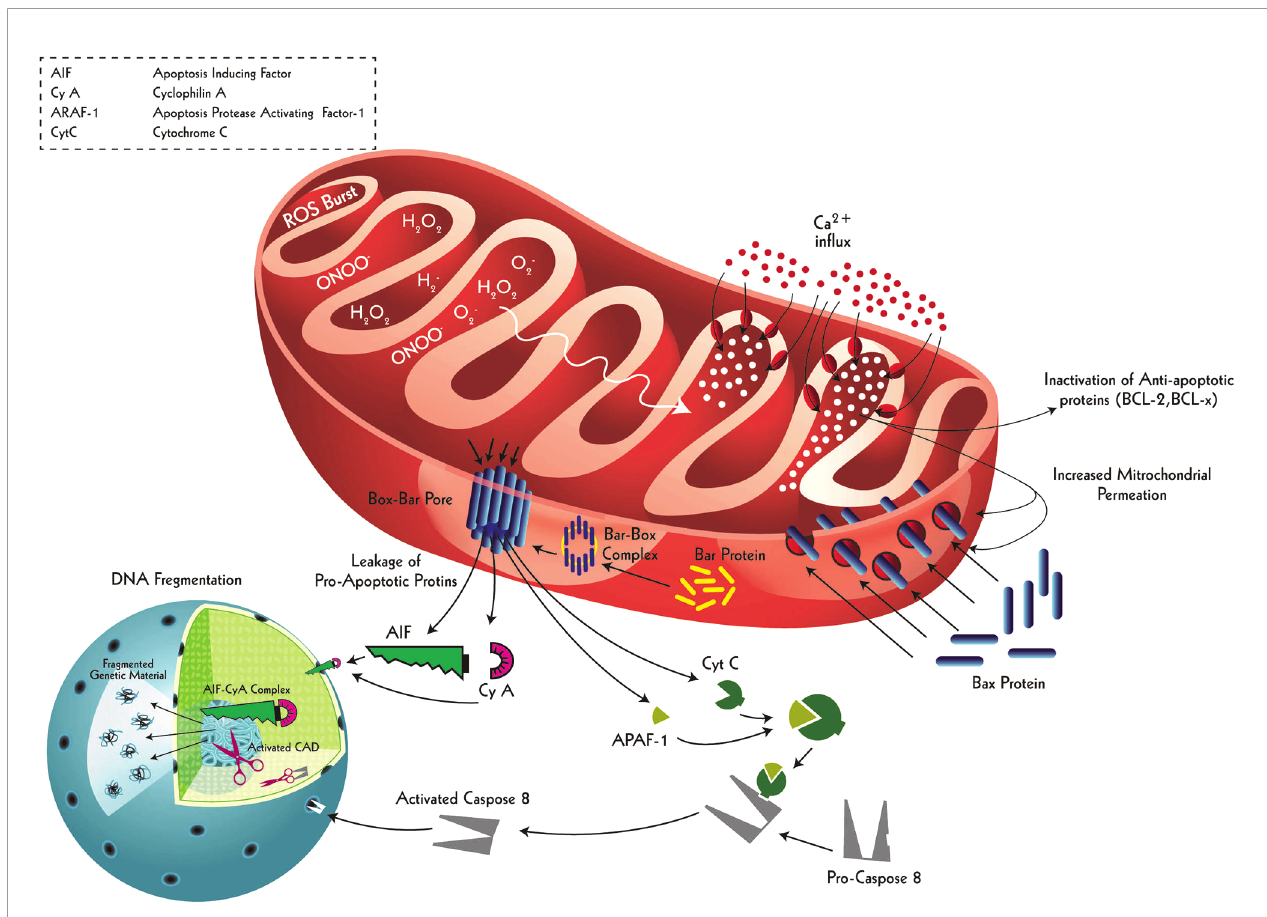
FIGURE 6 | Intrinsic apoptotic signaling and resultant neuronal death driven by ischemic-induced ROS burst. Ischemic events cause mitochondrial matrix of the neurons uptake extracellular calcium as a result of augmented mitochondrial respiratory burst. This calcium accumulation not only causes inactivation of anti- apoptotic proteins (BCL-2 and BCL-x) inside mitochondria but also results in an increase in the permeability of the outer and inner mitochondrial membranes. This permeation allows cytoplasmic Bax proteins to enter and make ‘ tunnel-like ’ complexes with mitochondrial Bar proteins, which then embed into the outer mitochondrial membrane as Bax-Bar pores. These specialized pores serve as channels to transport intra-mitochondrial pro-apoptotic proteins (AIF, Cy A, APAF-1, and Cyt C) into the cytoplasm. The AIF and Cy A make a complex (AIF-Cy A complex), directly entering the nucleus to in fl ict defragmentation. Similarly, APAF-1 binds with Cyt C to transform pro-Caspase 8 protein into an active form: Caspase 8. The Caspase 8 enters through the nuclear pores to activate Caspase Activated DNase (CAD) which defragments the nuclear material, a key apoptotic signaling outcome. This dual apoptotic signaling effect is primarily initiated by a respiratory burst in the affected neuron following ischemic